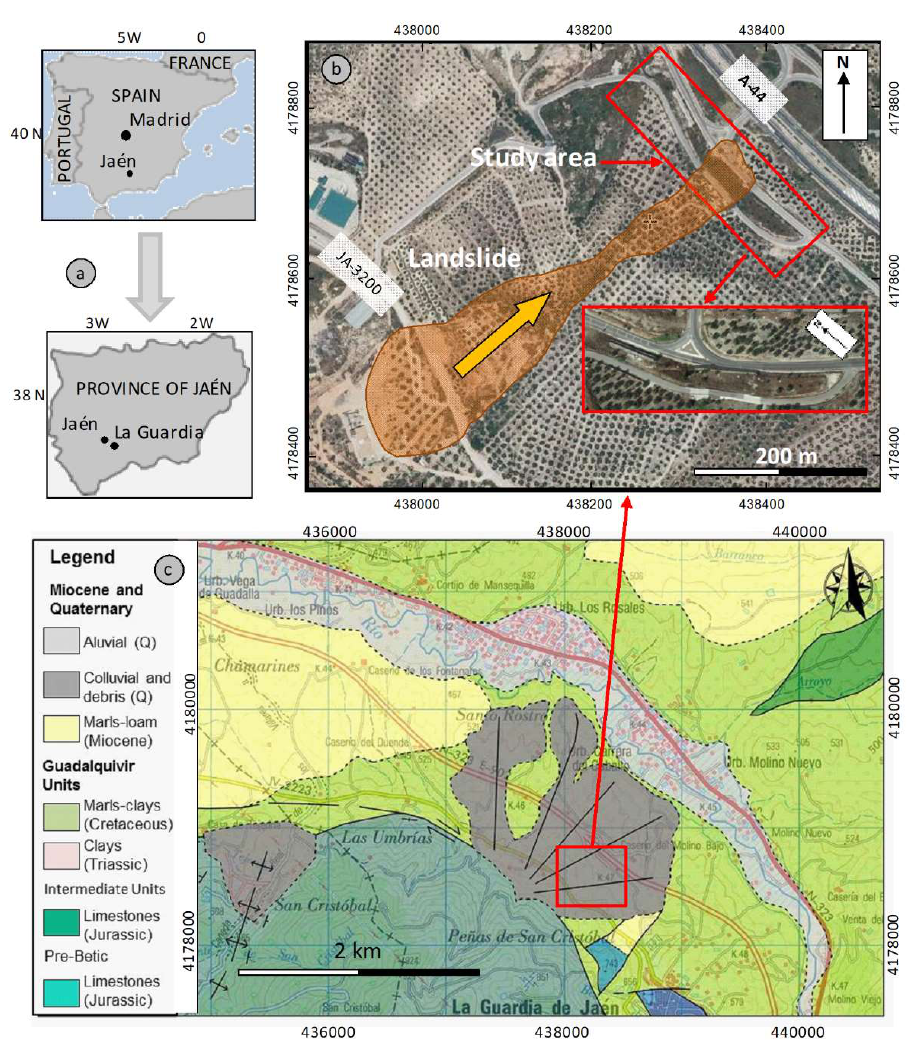
Figure 1. Geographical location and geological setting: ( a ) Geographical location; ( b ) Landslide and study area; ( c ) Geological setting (taken from the Geological Map of Spain at scale 1:50,000, [65]). Coordinates are in ETRS89-UTM-30N.